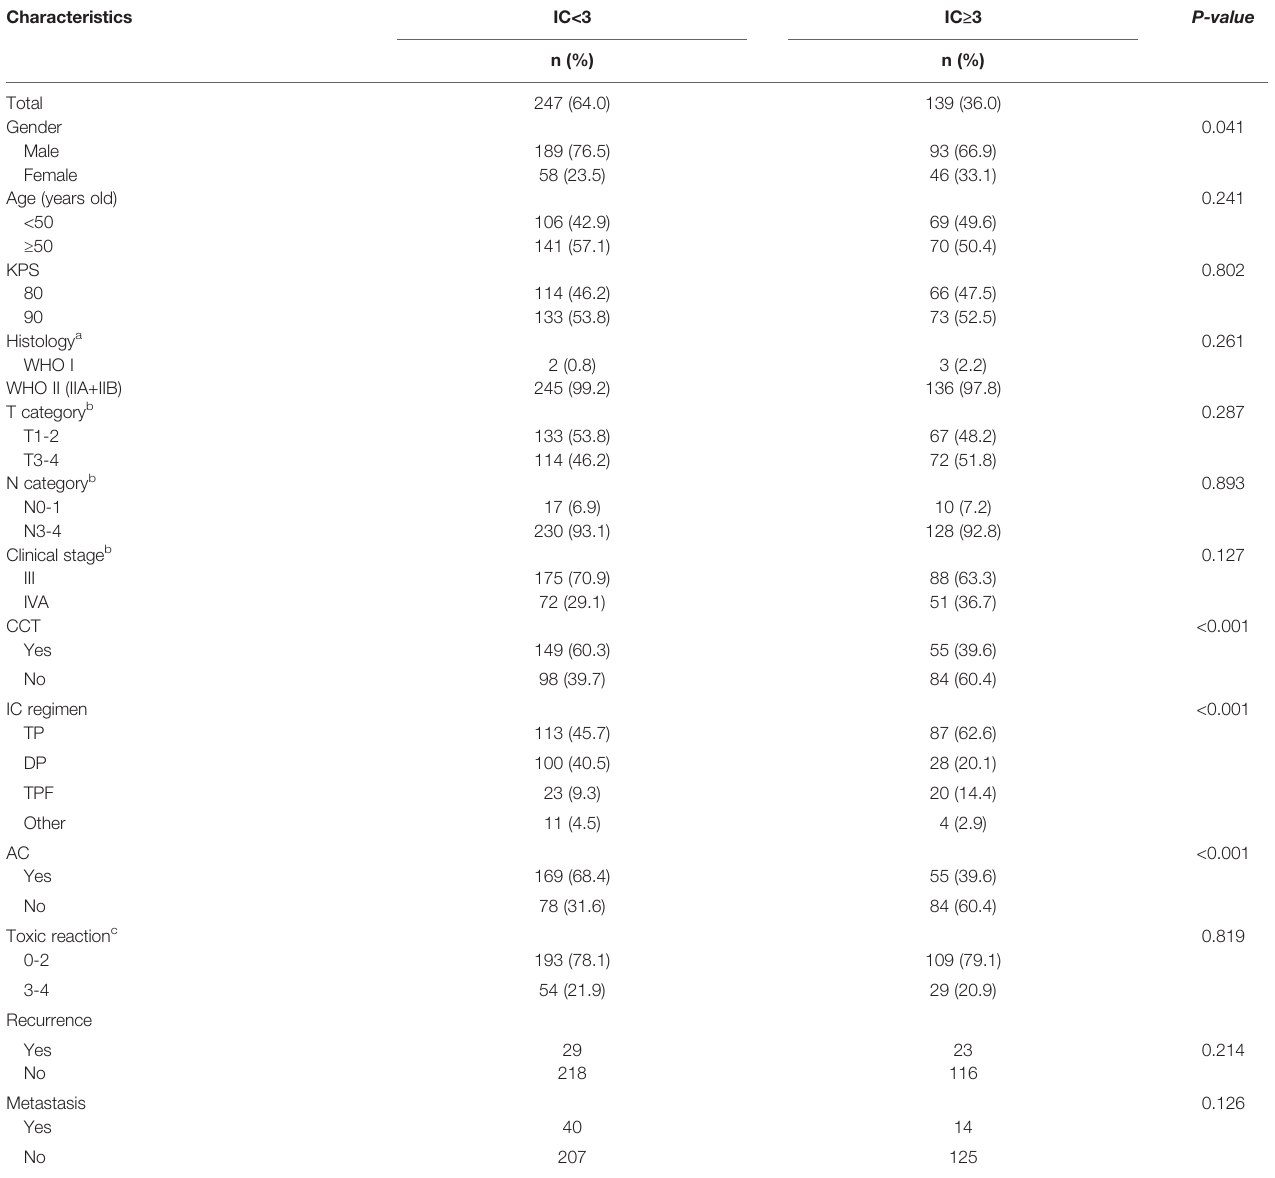
TABLE 1 | Basic characteristics of the patients in the IC <3 and IC ≥ 3 groups.